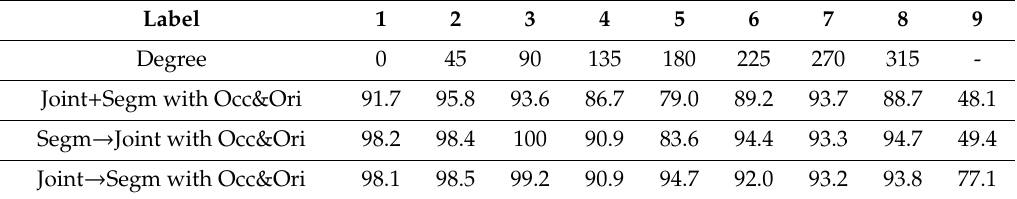
Table 4. Accuracy of orientation recognition when a neighbor error allowed (%).